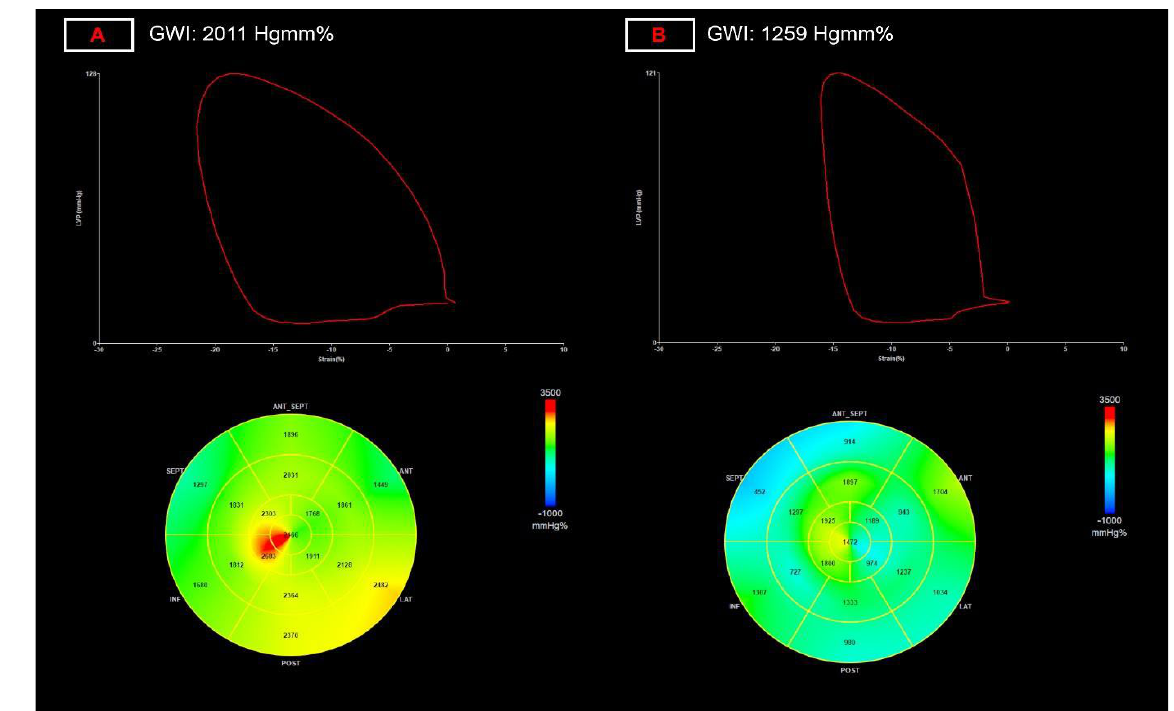
Figure 2. Representation of alterations global myocardial work index (GWI) measurement. ( A ) panel: normal left ventricular myocardial work index of 2011 Hgmm%; ( B ) panel: decreased left ventricular myocardial work index of 1259 Hgmm%, after COVID-19 infection. 3.4. Dimensional and Functional Parameters of the Right-Side of the Heart Dimensions of the right heart did not show statistical difference between the two groups. Among functional parameters, tricuspid annular plane systolic excursion val- ues were significantly decreased in post-COVID patients (23.75 ± 2.8 vs. 22.5 ± 3.4